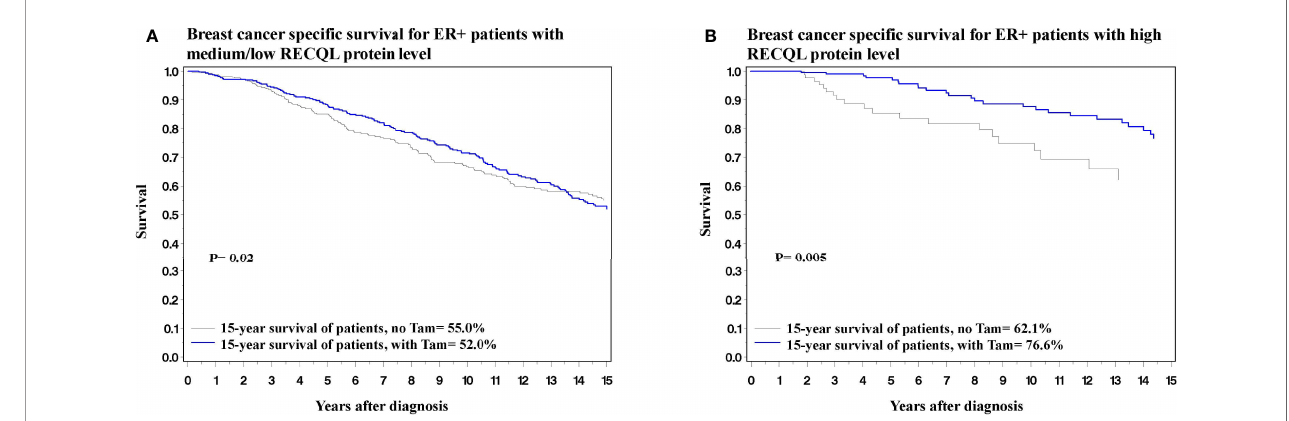
FIGURE 3 | Breast cancer speci fi c survival among ER-positive patients based on Tamoxifen treatment. (A) Breast cancer speci fi c survival among ER-positive patients with medium/low level of RECQL protein based on Tamoxifen treatment. (B) Breast cancer speci fi c survival among ER-positive patients with high level of RECQL protein based on Tamoxifen